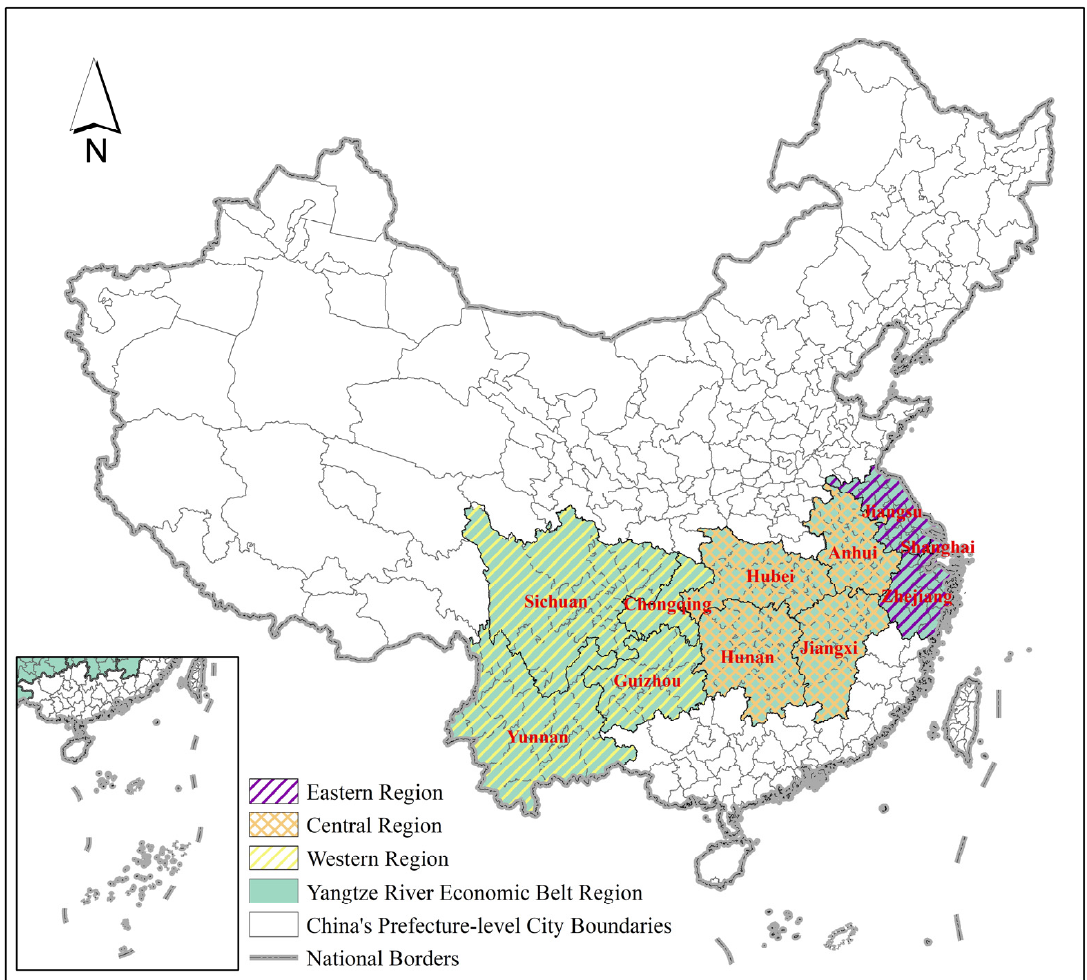
Figure 2. Study Area.